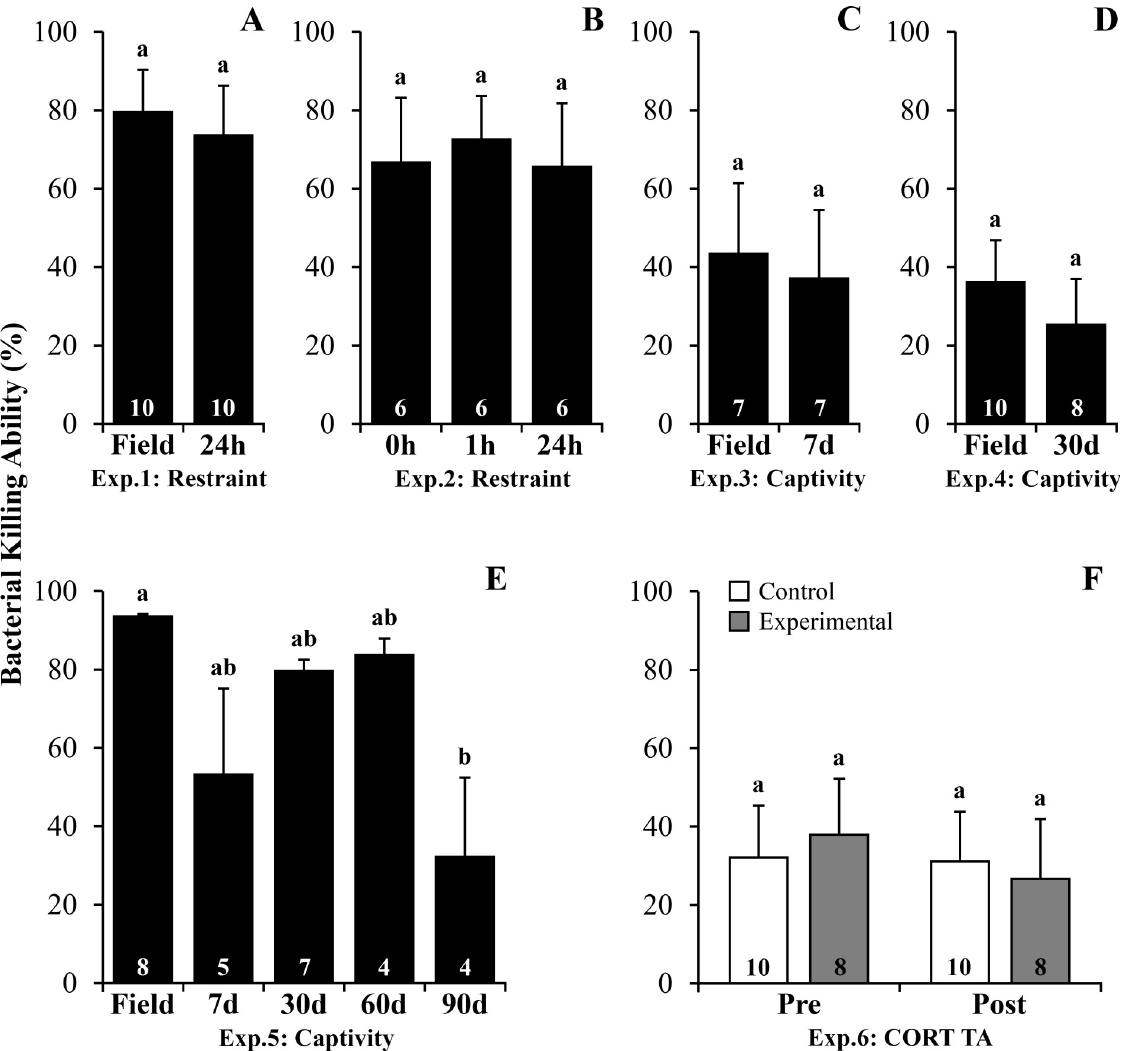
Fig 3. Bacterial killing ability following stressors and corticosterone transdermal application in R . ornata toads. (A) Experiment 1: Restraint–field vs . 24h. (B) Experiment 2: Restraint– 0h vs . 1h vs . 24h. (C) Experiment 3: Captivity–field vs . 7 days. (D) Experiment 4: Captivity–field vs . 30 days. (E) Experiment 5: Captivity–field vs . 7 vs . 30 vs . 60 vs . 90 days. (F) Experiment 6: Corticosterone transdermal application. Bars represent mean ± standard error. The N is indicated inside each bar. Letters above the bars represent statistical differences for Bonferroni adjustments in ANOVAs or Student t-test, with different letters representing statistical difference within groups with P � 0.05. Abbreviation: Exp.: Experiment; CORT TA: Corticosterone transdermal application. Legend: Control: control and placebo group; Experimental: corticosterone